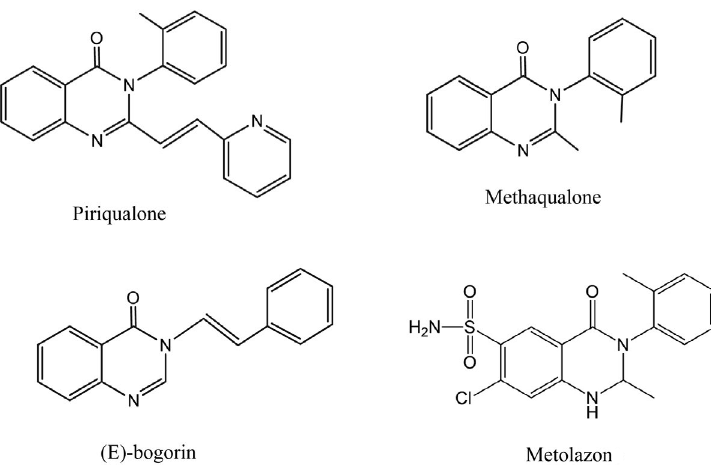
Fig. 1. Selected examples of quinazolin analogues with pharmacological activities